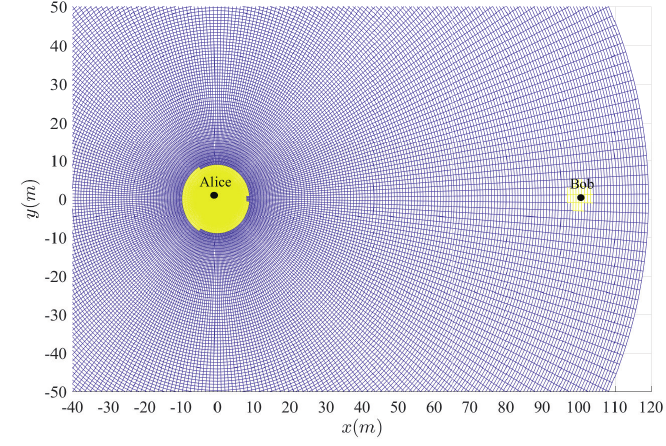
Figure 4. Insecure region with P th e = 15 dBm, N a = 10 and ρ = 10 − 8 .